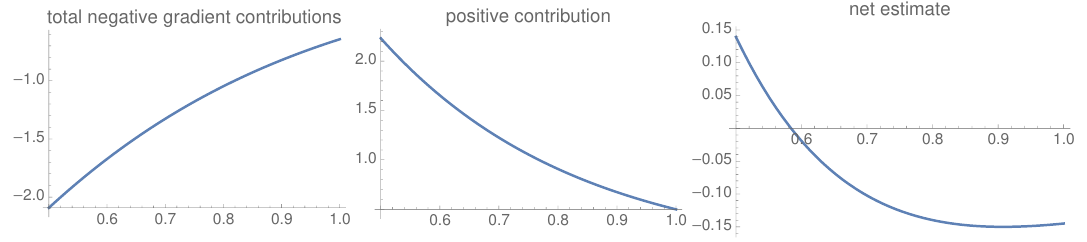
Figure 7: The relative sizes of the positive, negative, and net contributions